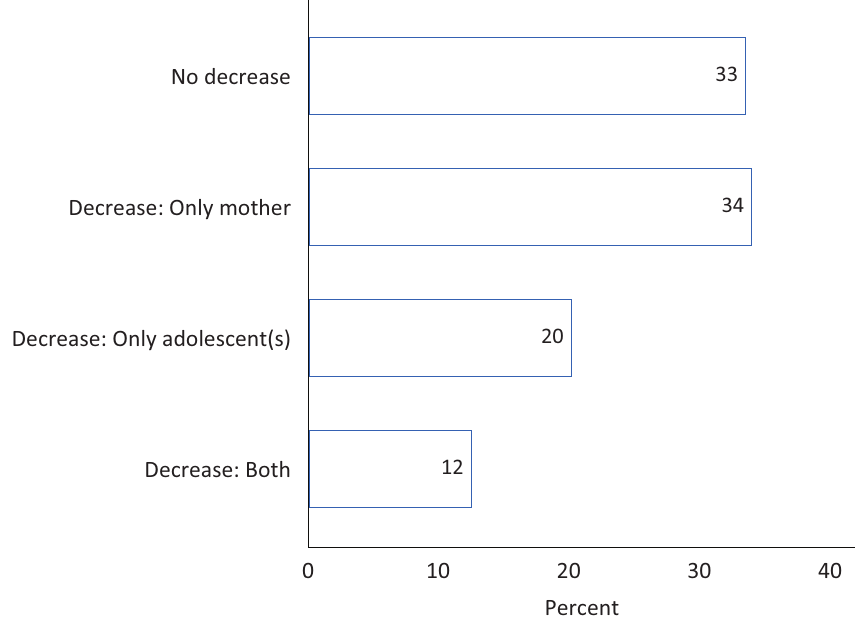
Figure 2. Within‐family constellations of decreases in family climate: Adolescents and mothers. Notes: N = 188 families with both mother and adolescents observed; weighted. Source: Authors’ work based on Kuger et al. (2020,